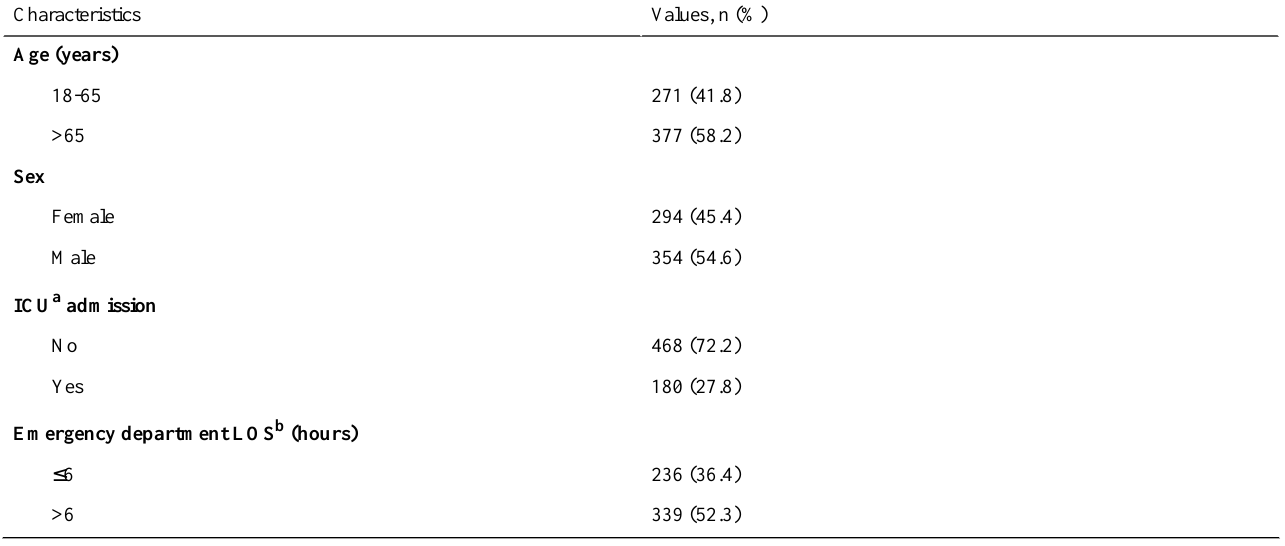
Table 1. Postpilot rollout phase patient demographics (N=648).